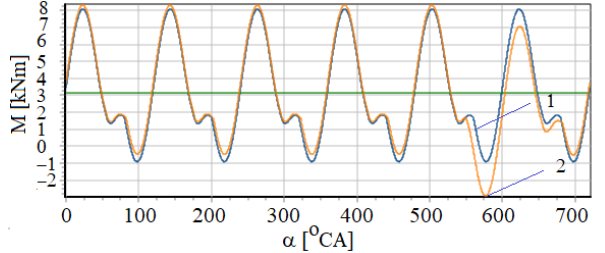
Fig. 3. The chart of engine torque as a function of an angle of crankshaft rotation for: 1 – operational engine, 2 – damaged engine (reducing the dose of fuel supplied to cylinder No. 1 by 50%) The analysis of the waveforms presented in Fig. 1 and 2 clearly indicates that a working process occurring in cylin- ders (indicated pressure) affects the torque values.